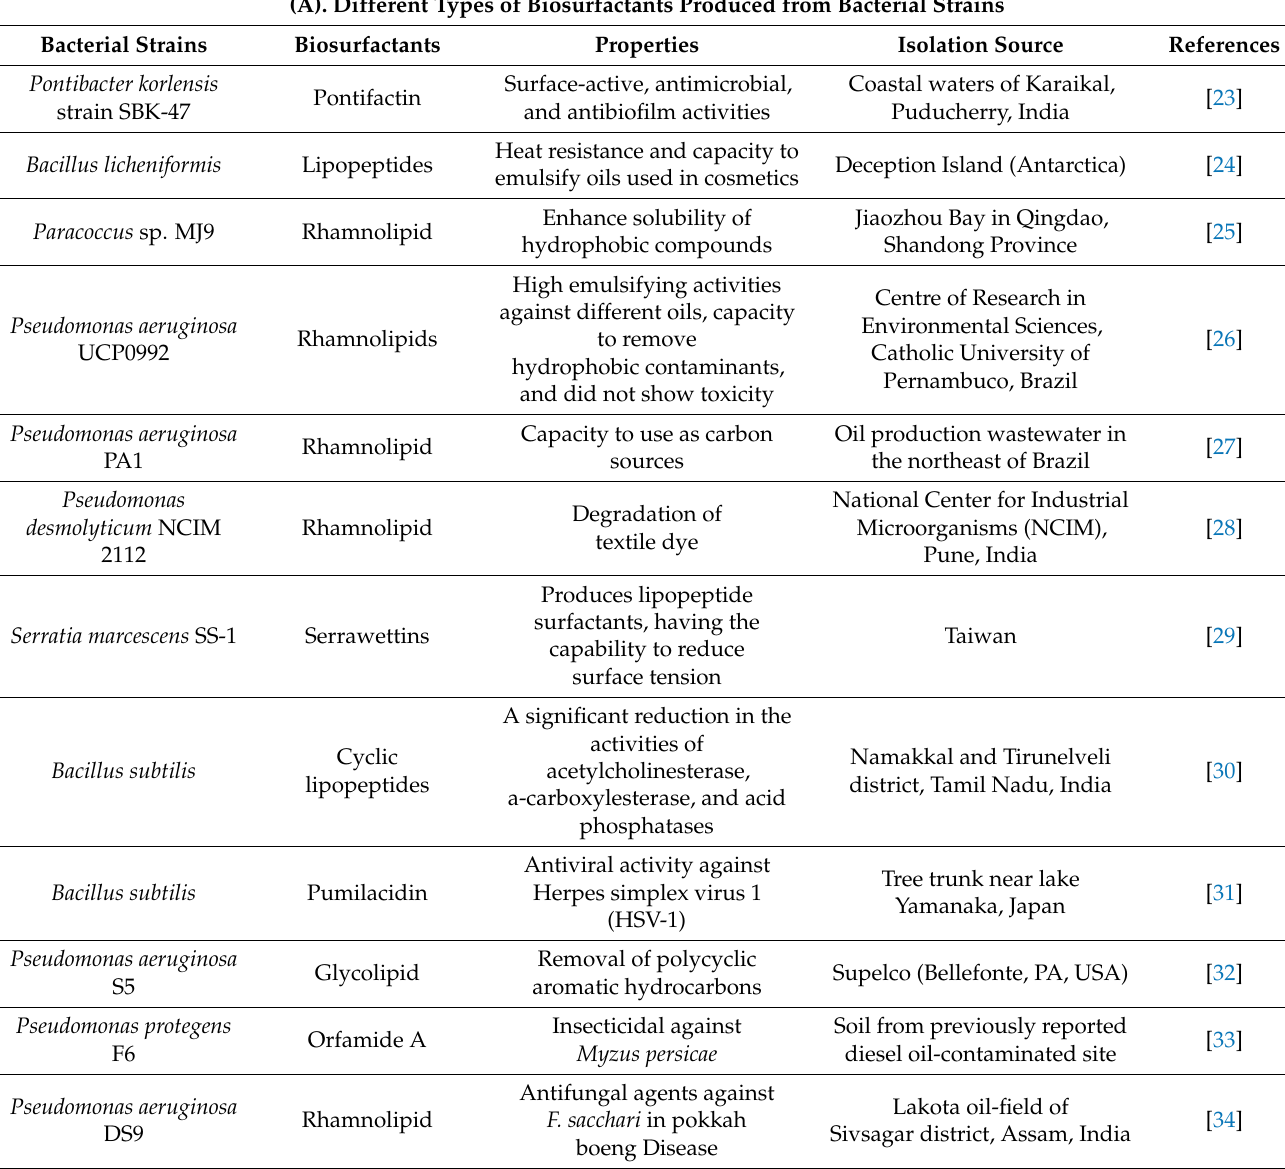
Table 2. ( A ). Different types of biosurfactants produced from bacterial strains. ( B ). Different types of biosurfactants produced from fungal strains. ( C ). Different types of biosurfactants produced from yeast strains. (A). Different Types of Biosurfactants Produced from Bacterial Strains Bacterial